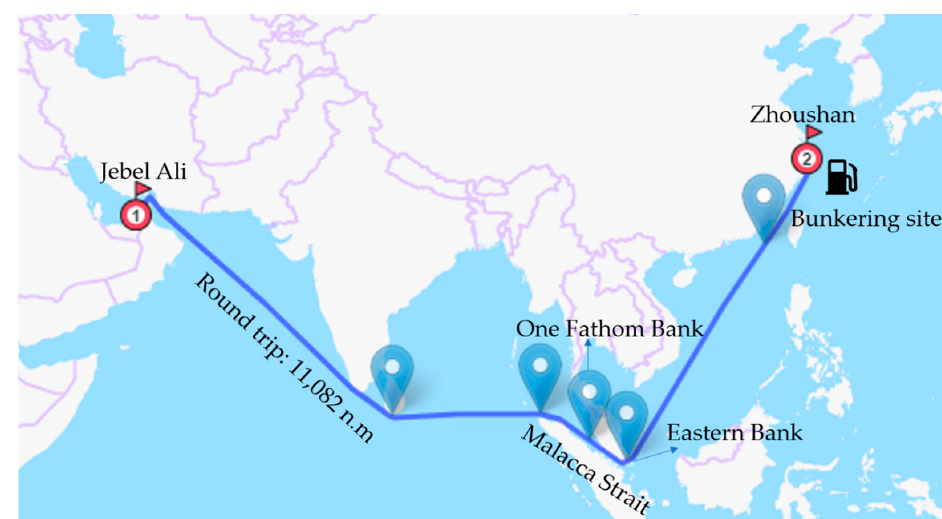
Figure 2. Shipping route and bunkering site.